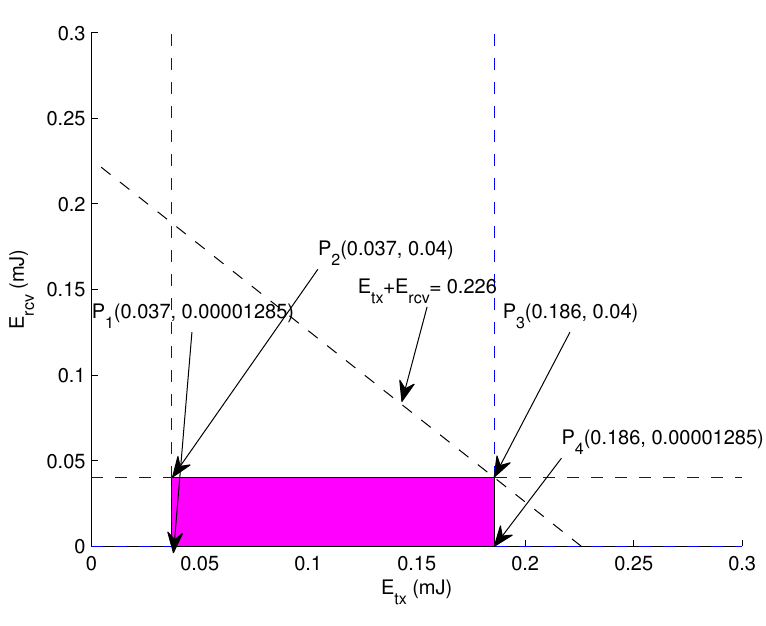
Figure 3. Feasible Region: